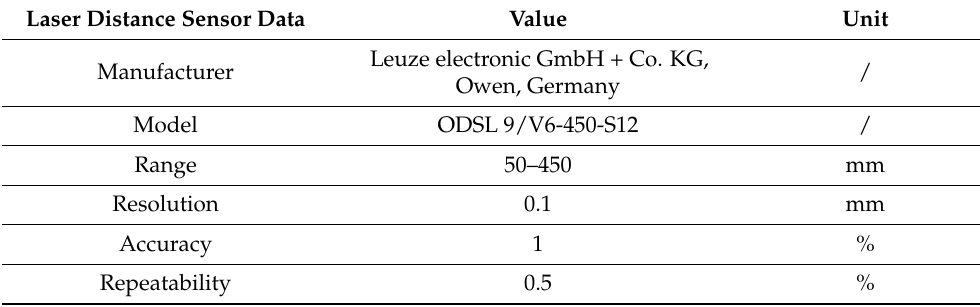
Table 3. Table of laser distance sensor parameters [25].